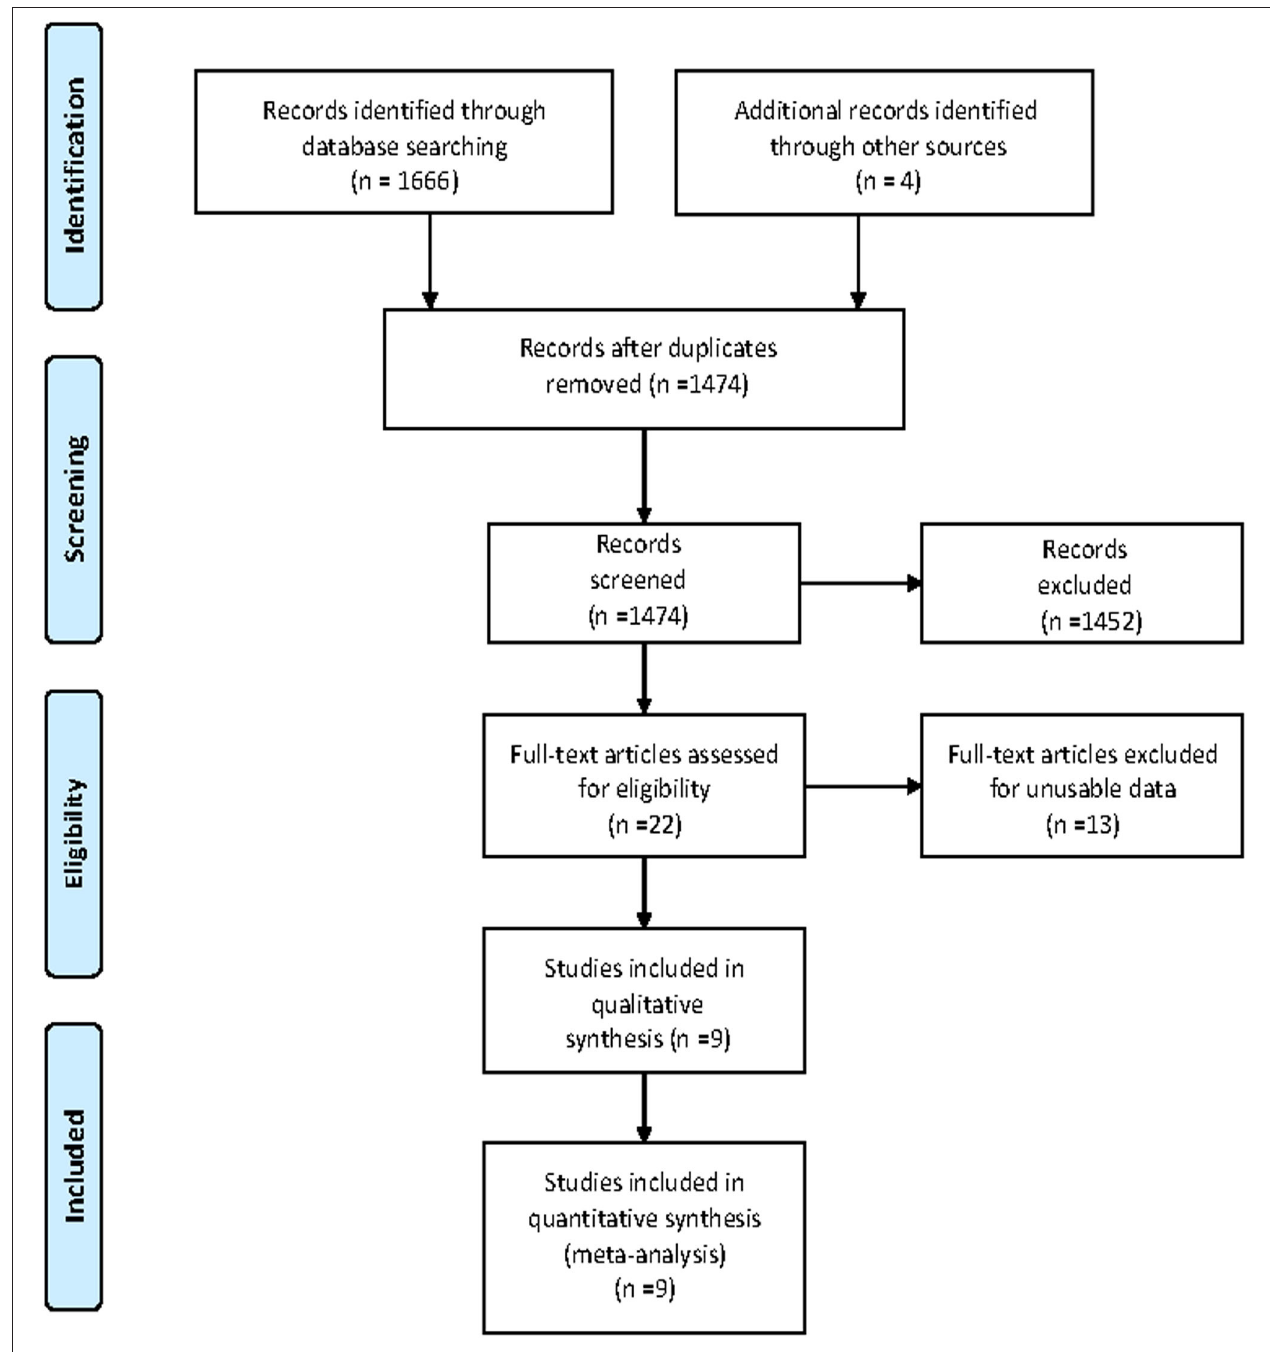
FIGURE 1 | Flow chart for study searching and selection process.